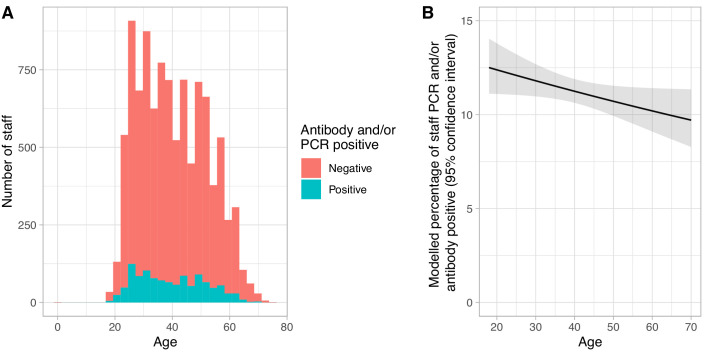
Relationship between age and Covid-19 infection in hospital staff.Panel A shows a histogram of staff ages for those attending asymptomatic screening, staff with a positive SARS-CoV-2 IgG antibody and/or PCR test at their first asymptomatic clinic attendance as shown in blue and those who were both PCR and antibody negative are shown in red. Panel B shows the univariable modelled percentage of staff positive by age, the solid line shows the expected value and the ribbon the 95% confidence interval.